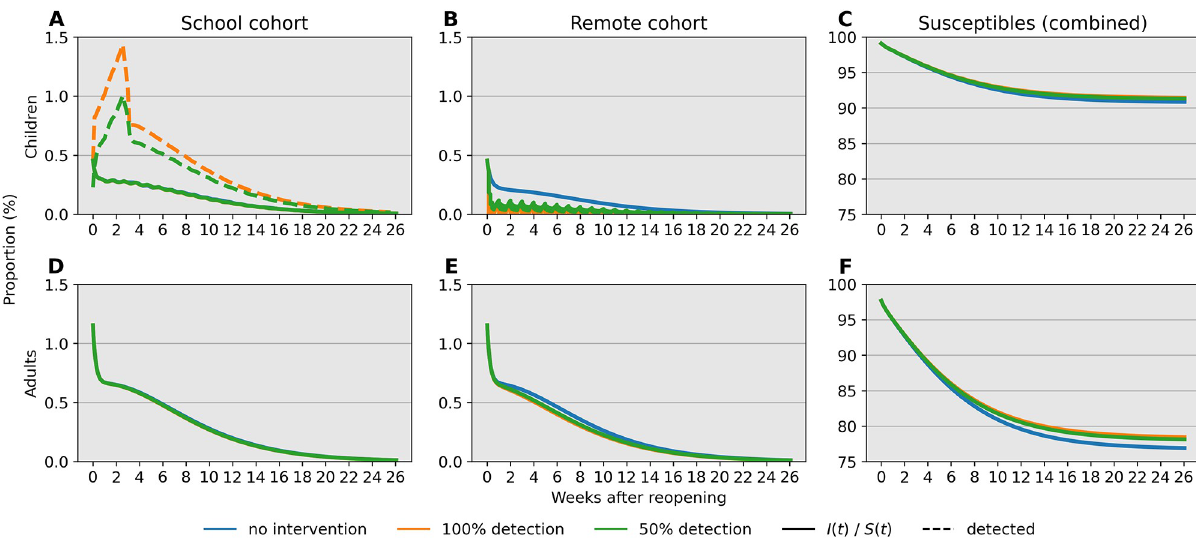
Fig 5. Comparison of cumulative under the parallel cohort approach. (A-C) The 14-day prevalence criteria increases over the first 4 weeks, but point prevalence consistently trends downward due to cohort structure. Over 90% of children are kept safe from infection under the conditions of this simulation. (D-F) The combination of testing in children and cohort separation prevents a high level of infection in adults.